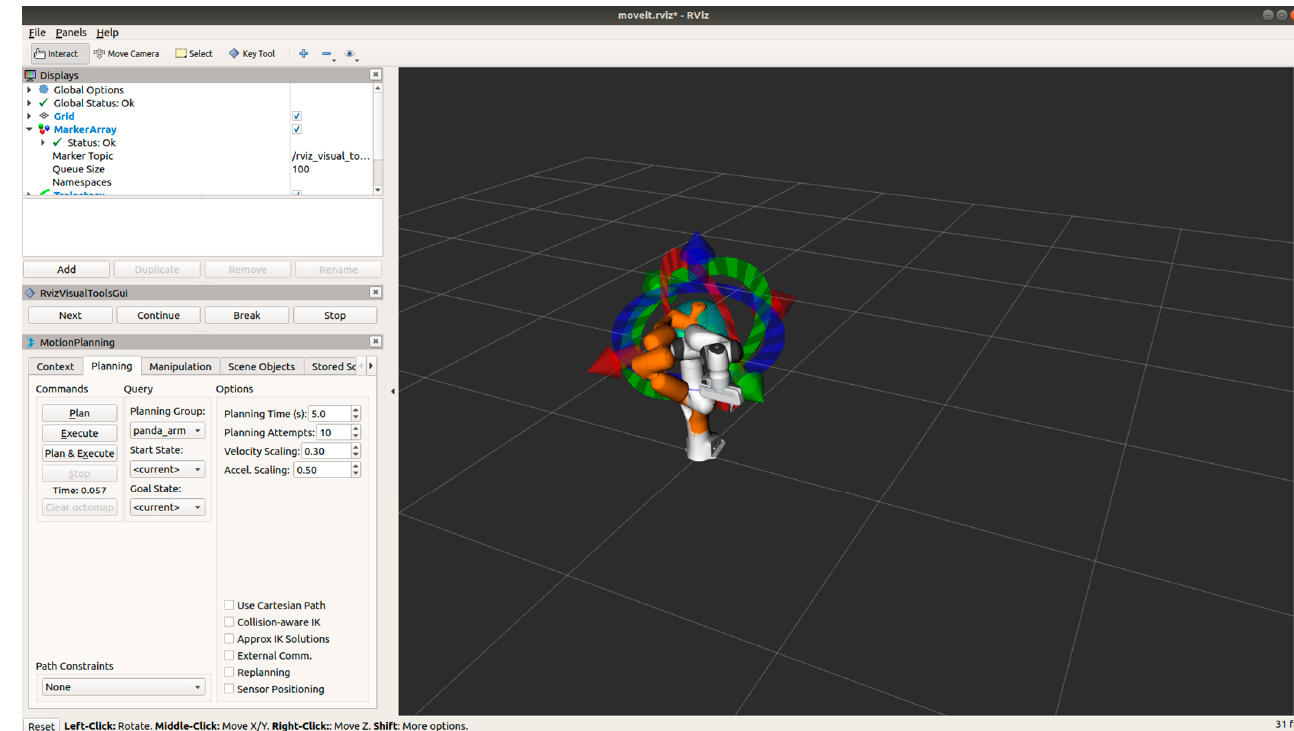
Figure 4. Screenshot of motion planning configuration displayed in RVIZ control panel.